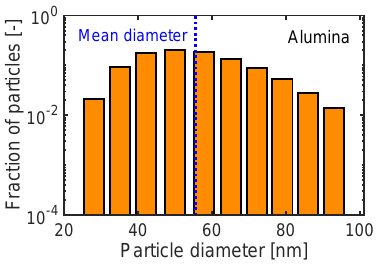
Figure 3. Fraction of the alumina particle size based on the reference [49].